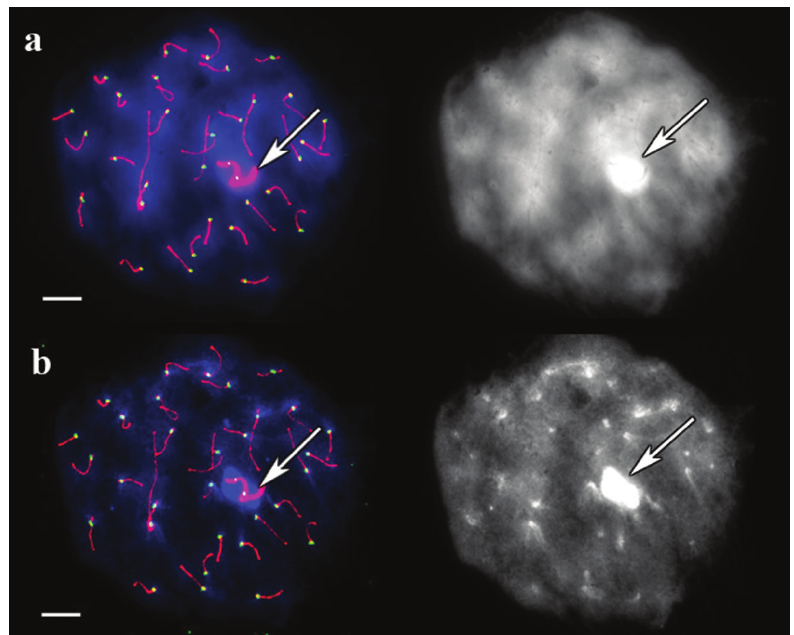
Figure 2. SC spread in guinea pig . a A cell after immunostaining, prior to barium hydroxide treatment. Left: Red, green and blue indicate SCs, centromeres, and DAPI, respectively. Right: the same image, DAPI channel separately b The same cell after 5 minutes of barium hydroxide treatment. Left: Red, green and blue indicate SCs, centromeres, and DAPI, respectively. Right: the same image, DAPI channel sepa- rately. Arrows indicate sex bivalent. Scale bars = 20